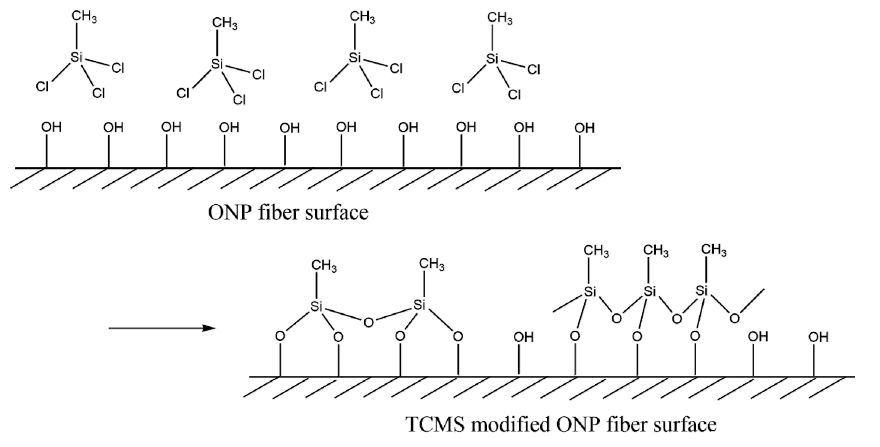
Figure 5. Formation of polymethylsilsesquioxane (PMS) on ONP fiber surface.